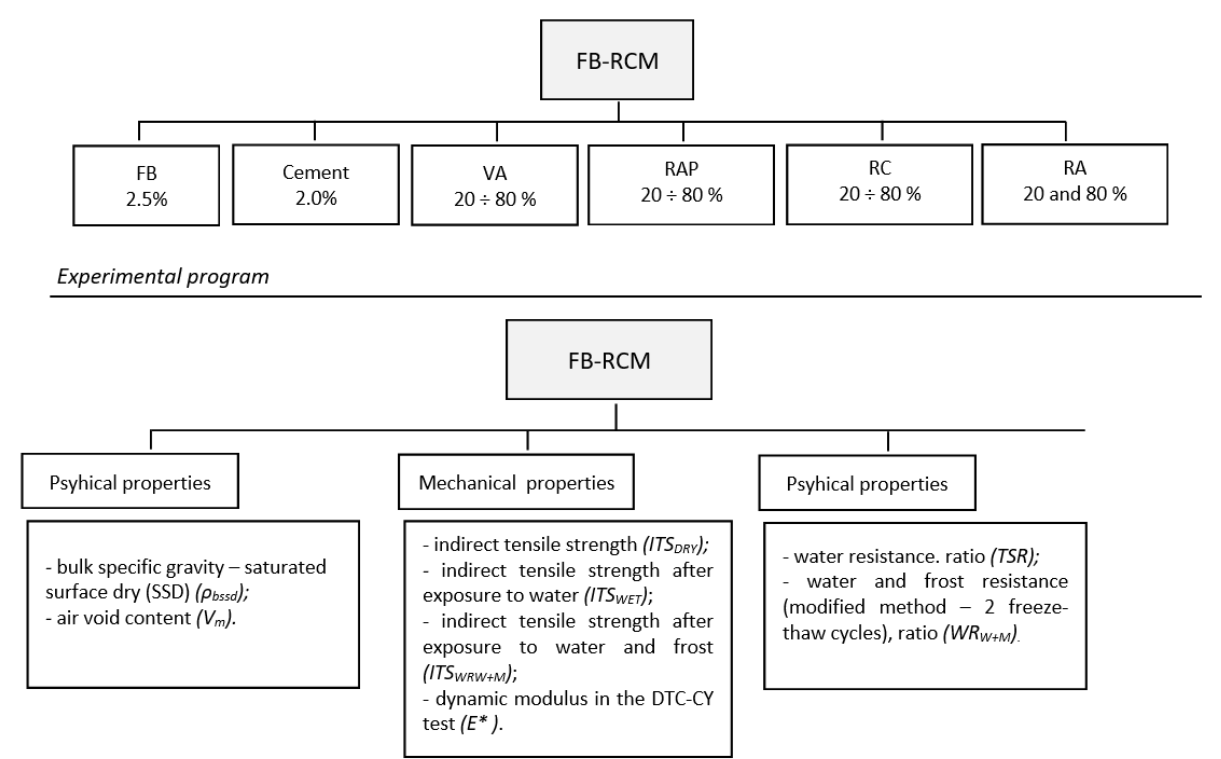
Figure 1. Experimental design.